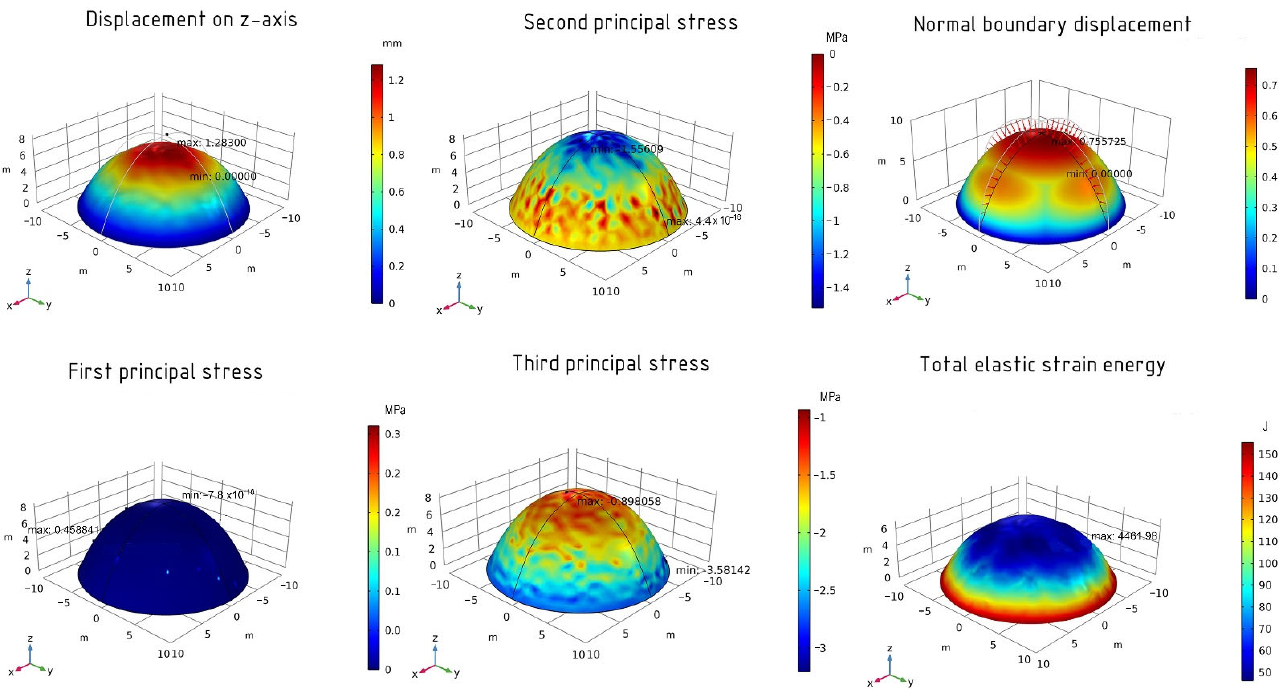
Figure 11. The results of the optimized shell using the SNOPT method. Then, the calculation is carried out using the Interior Point OPTimizer or IPOPT. On the z ‐ axis, the maximum displacement value is 1.16 mm. The first principal stress has the following values: 1.38 MPa (maximum) and − 1.1 × 10 − 15 MPa (minimum). For the second principal stress, the maximum value is 1.07 MPa and the minimum value is − 1.57 MPa. The values of the third principal stress are 5.1 × 10 − 17 MPa (maximum) and − 2.81 MPa (minimum). The normal boundary displacement for the optimized shell is 107% and the total elastic energy is 4157 J. The results are shown in Figure 12.